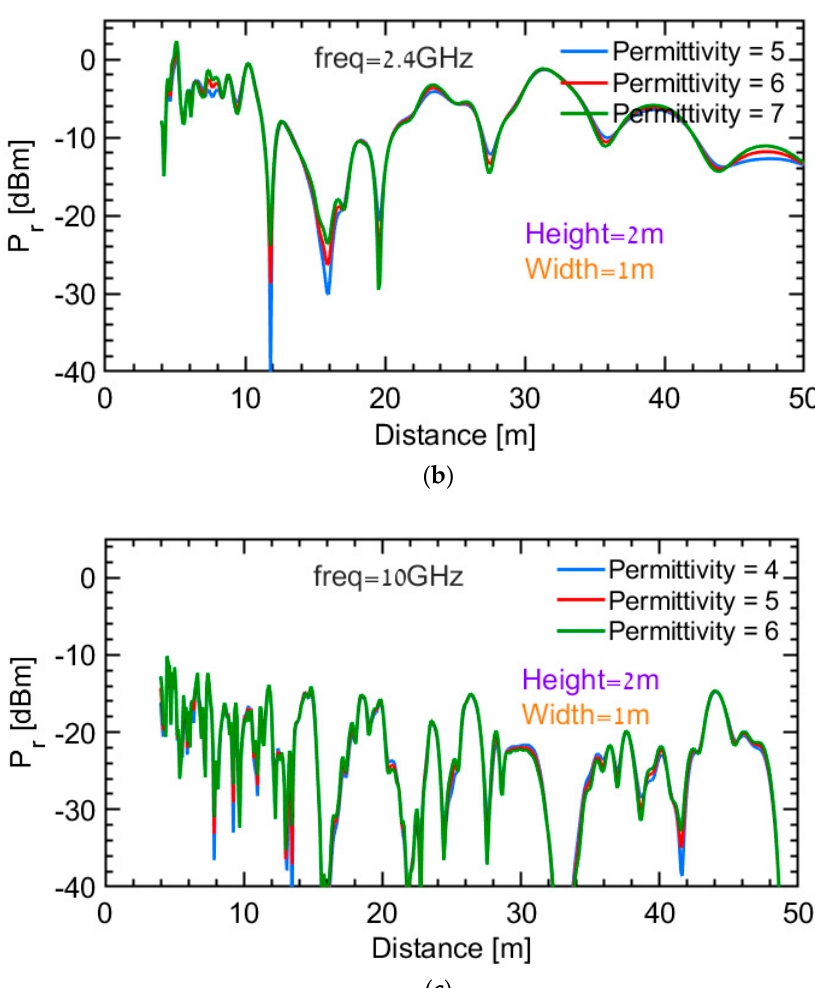
Figure 3. Simulations of the link budget along a pedestrian concrete tunnel considering different permittivity values for frequencies of ( a ) UHF 1 GHz, ( b ) UHF 2.4 GHz, and ( c ) SHF 10 GHz.